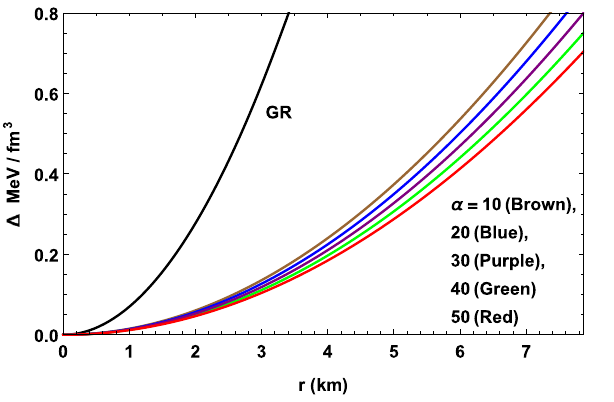
Fig. 4 Variation of anisotropy for 4U 1538-52 using the parameter provided in Table 1 and its trend in shown in Fig. 6.